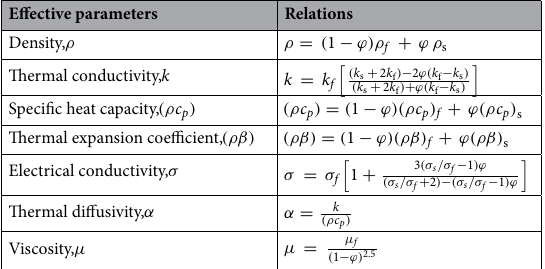
Effective parameters